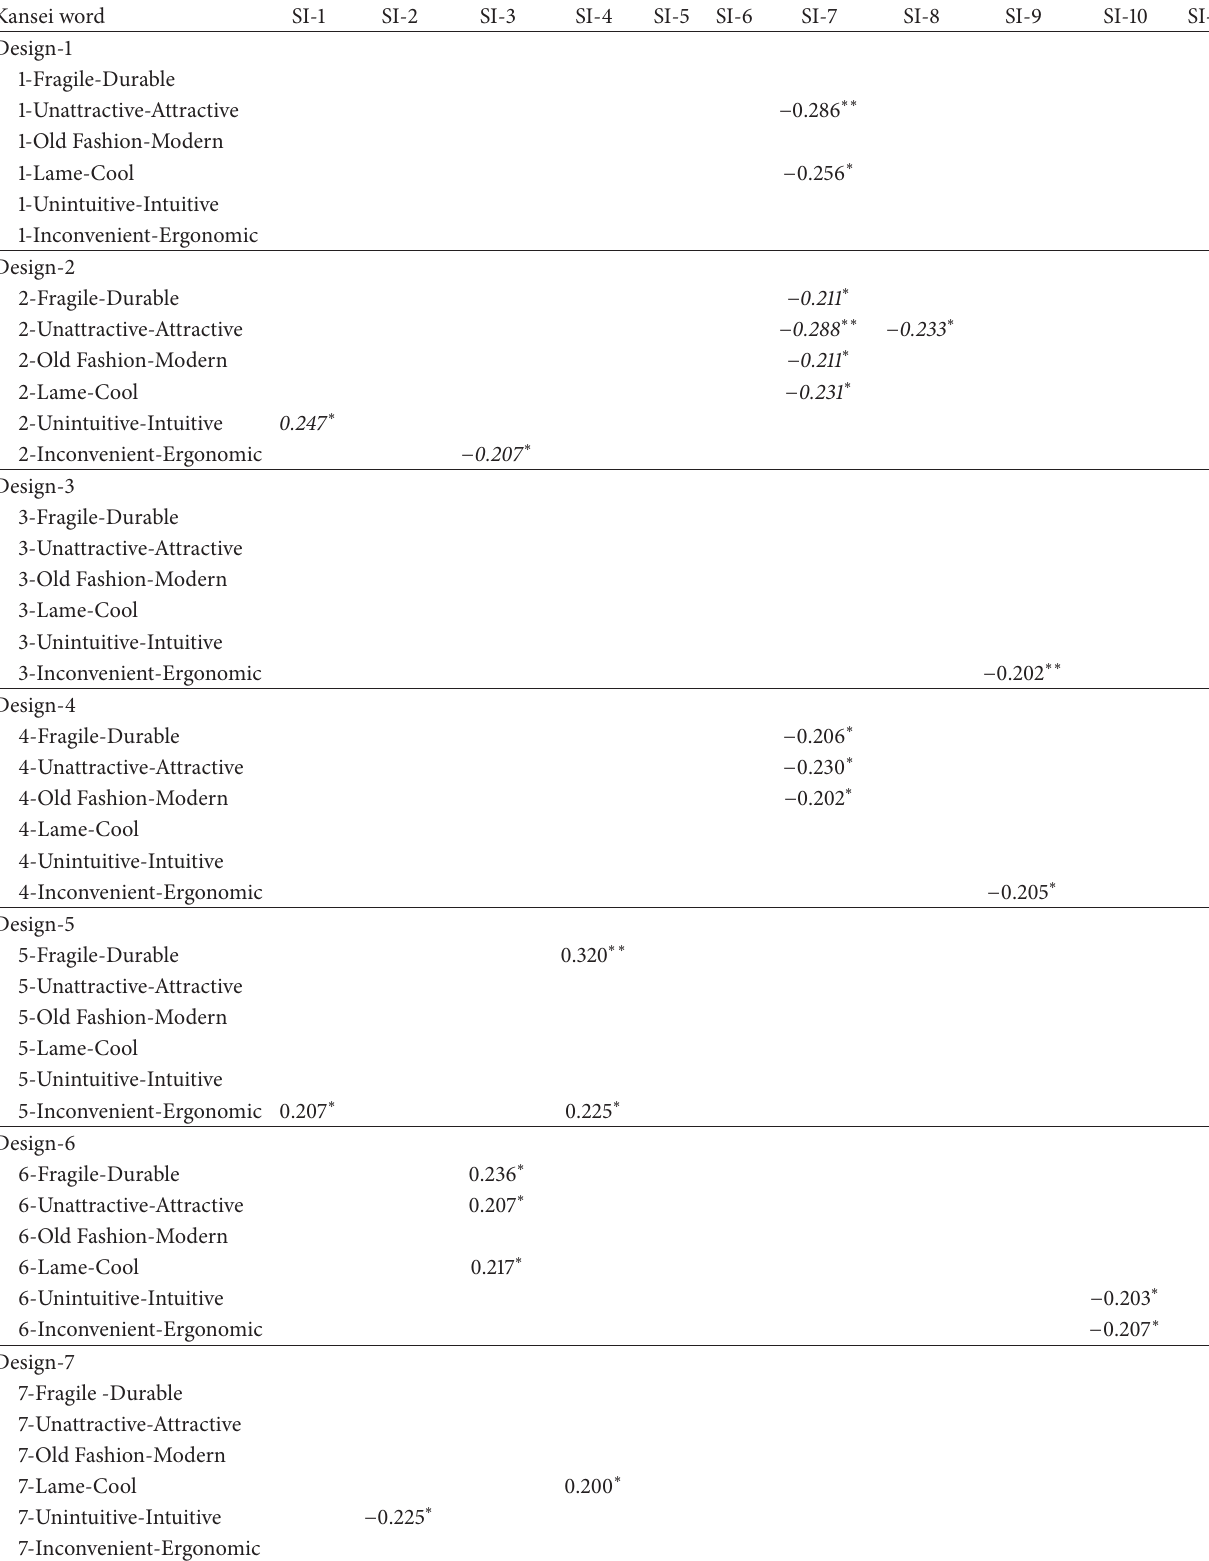
Table 16: The correlation between learning style and Kansei words based on the 8 designs